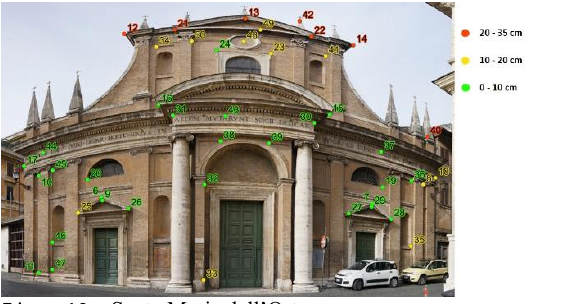
Figure 13 – Santa Maria dell’Orto